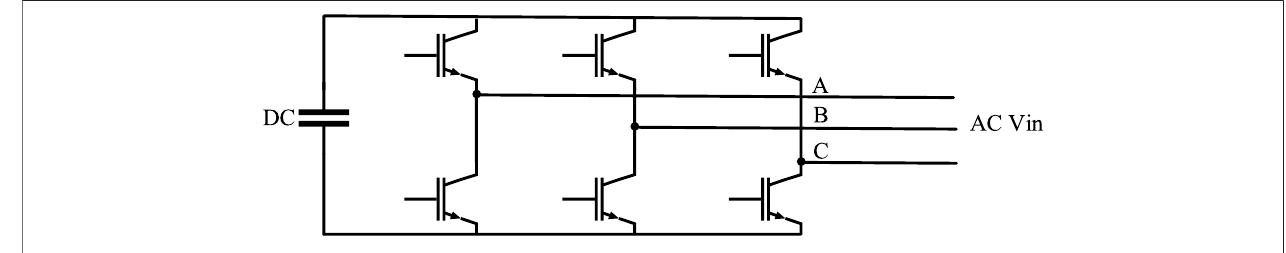
FIGURE 4 | Structure of the D-STATCOM.